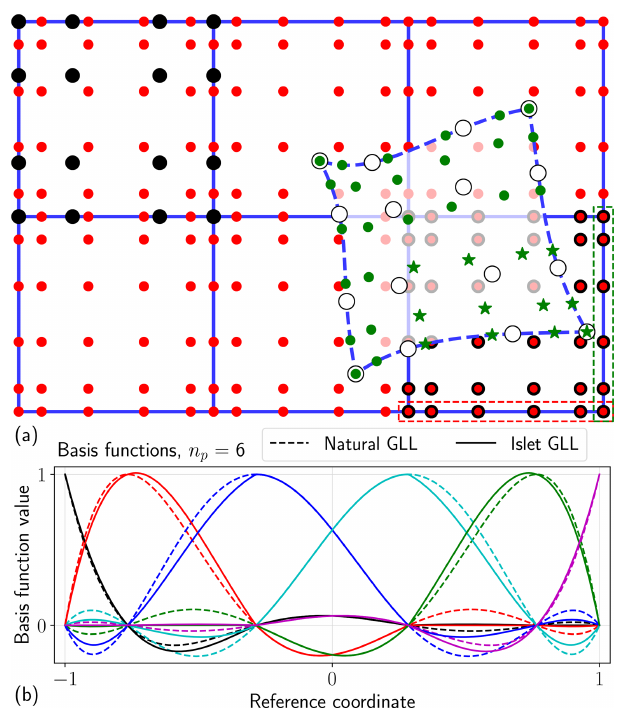
Figure 2. Diagram of the linear advection operation in a finite- element interpolation semi-Lagrangian time step. (a) Six spectral elements (blue solid lines) with an n t p = 6 tracer grid (red small circles). The black large circles in the upper-left element show the n v p = 4 dynamics grid. The upper-left Eulerian arrival element is advected backward in time to the right and down, resulting in the Lagrangian departure element (blue dashed outline, open circle dy- namics grid points, green tracer grid points). The domain of depen- dence of each green starred tracer grid point is the bottom right Eu- lerian element, with interpolation grid points (red small circles) as- sociated with this domain of dependence outlined in black. (b) The six 1D n t p = 6 element basis functions, a different color for each, for the natural GLL (dashed curves) and Islet GLL (solid curves) bases. In the bottom right Eulerian element, a set of 1D basis functions is conceptually associated with each of the red horizontal and green vertical rectangles outlining an element side, and a 2D basis func- tion over the element is a tensor product of one 1D basis function from each